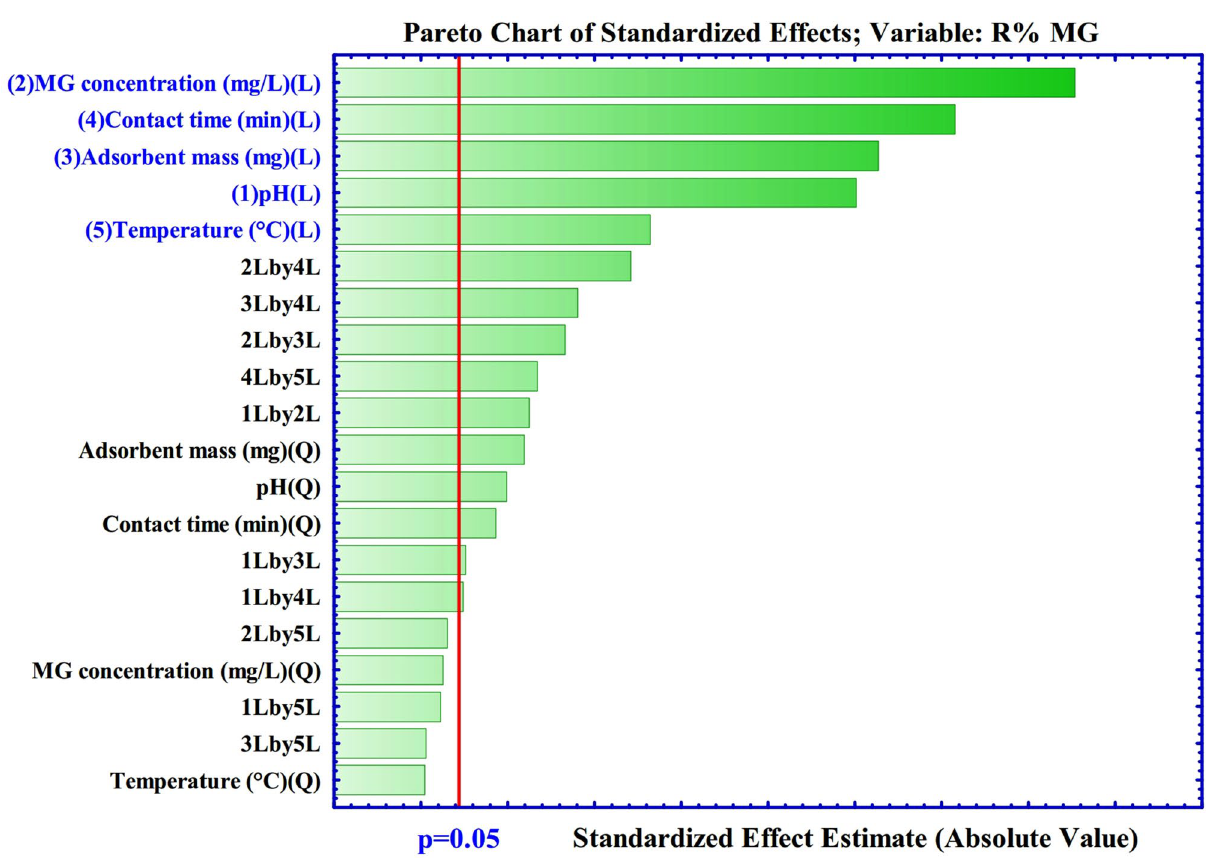
Figure 5. Pareto graph for the adsorption of MG